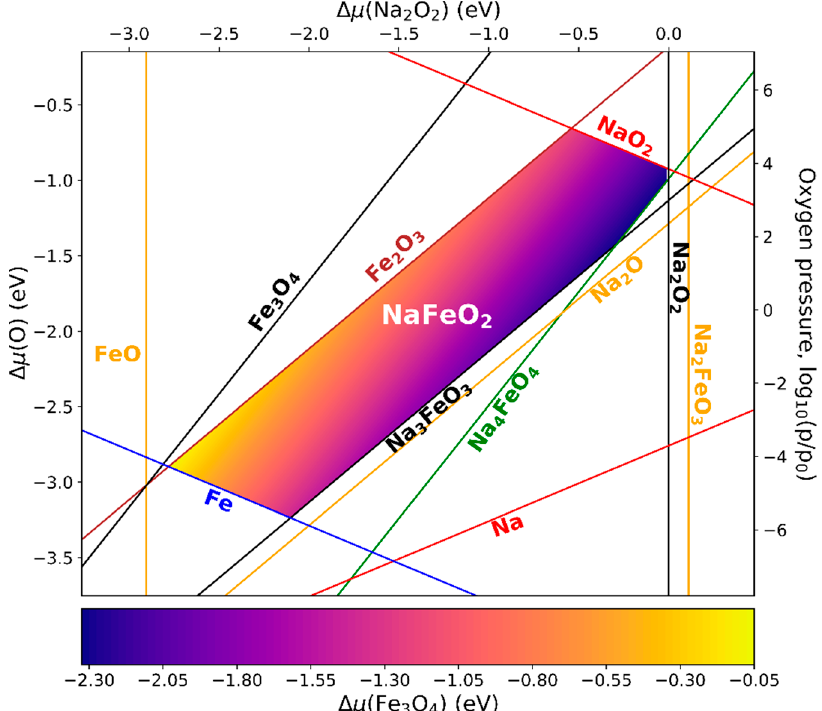
Figure 6. Phase diagram of NaFeO 2 with respect to the chemical potentials of Na 2 O 2 and oxygen. The vertical axis on the right is assigned to the corresponding oxygen gas pressure at a temperature of 900 K ( p 0 = 1 atm). The chemical potential of Fe 3 O 4 is visualized by color coding. The lines mark the transitions to the denoted secondary phases.